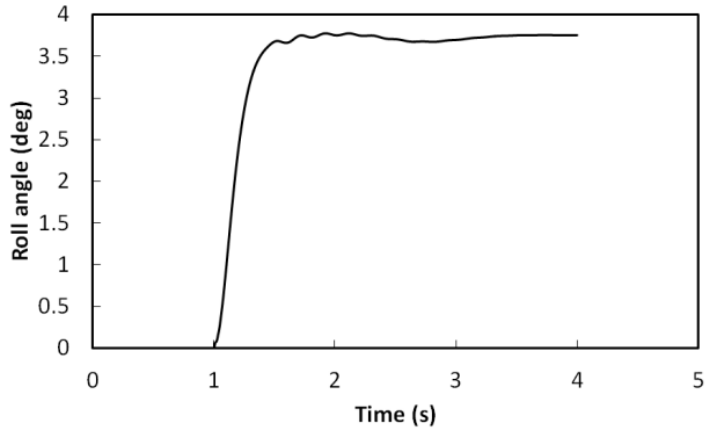
Figure 8. The roll